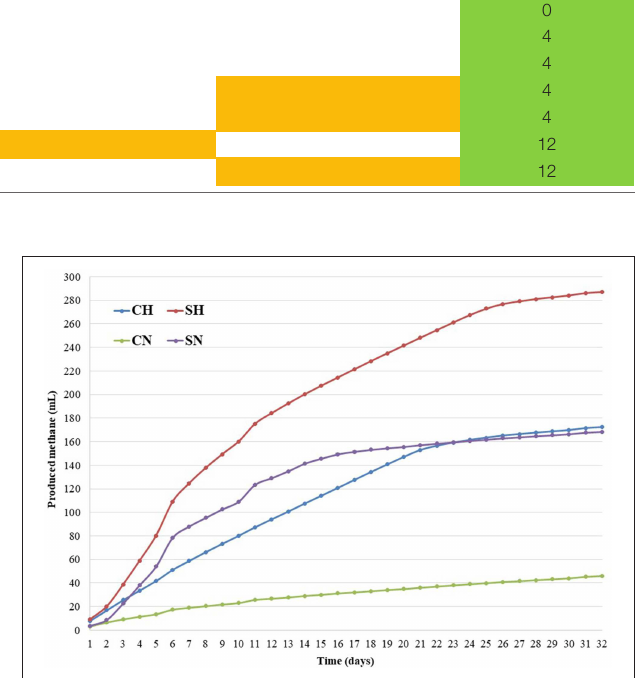
FIGURE 1 | Methane production in the batch reactors. Batch reactors were operated as described in Materials and Methods. The compositions of the reactors were: CN = biogas effluent, daily headspace replacement with nitrogen, CH = biogas effluent, daily headspace replacement with H 2 , SN and SH = same as CN and CH, respectively, but supplied with α -cellulose substrate at the start. The long-term experiments were repetitions of the